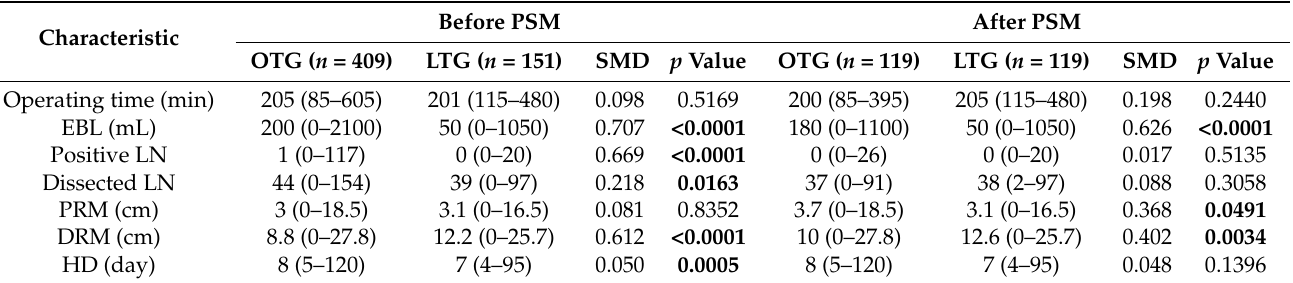
Table 2. Postoperative surgical